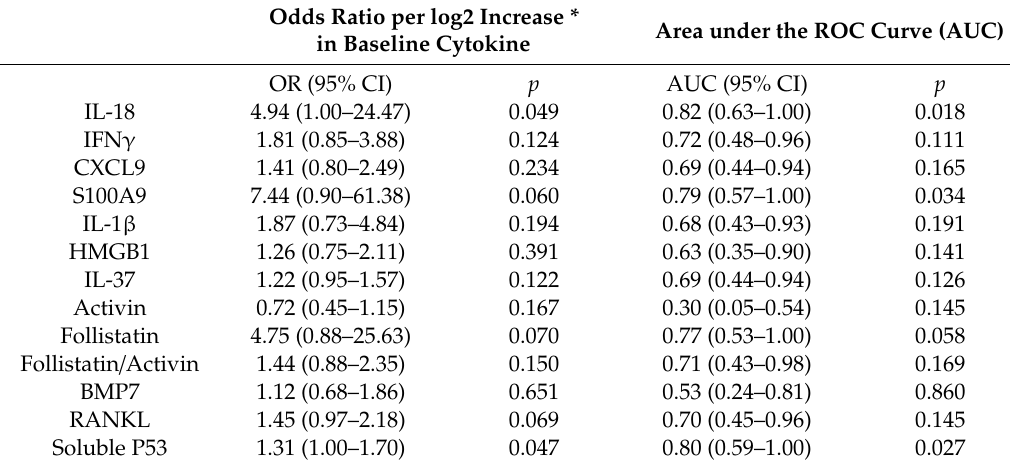
Table 4. Associations of baseline cytokine serum levels with non-response to asunercept treatment and corresponding predictive